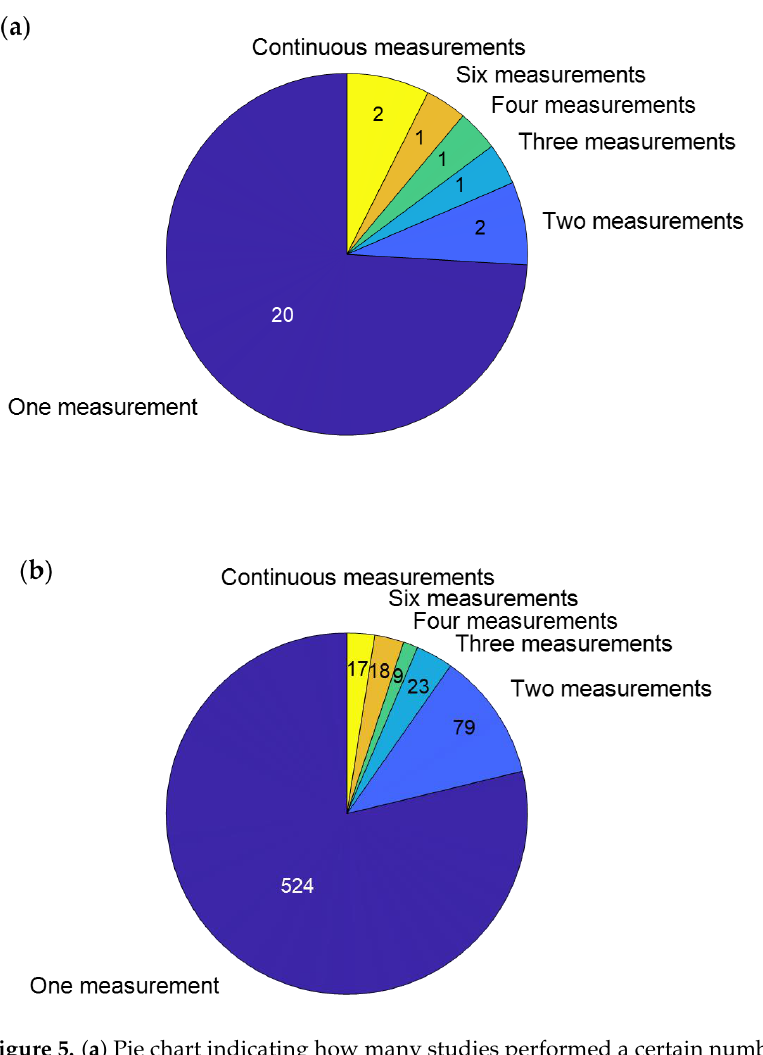
Figure 5. ( a ) Pie chart indicating how many studies performed a certain number of measurements. ( b ) Pie chart indicating how many patients from the studies combined were measured a certain number of times.